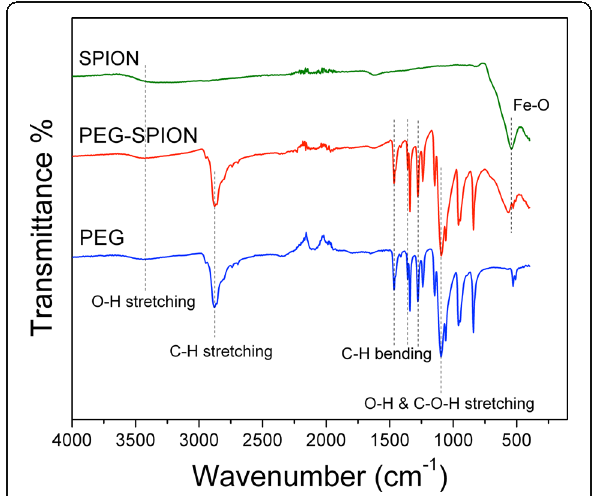
Fig. 1 ATR spectra of bare Fe3O4 nanoparticles (SPION), PEGylated Fe3O4 nanoparticles (PEG-SPION), and bare PEG